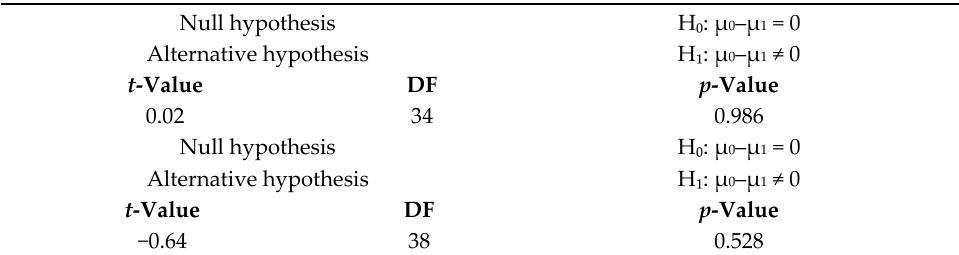
Figure 11. Gender t -tests.